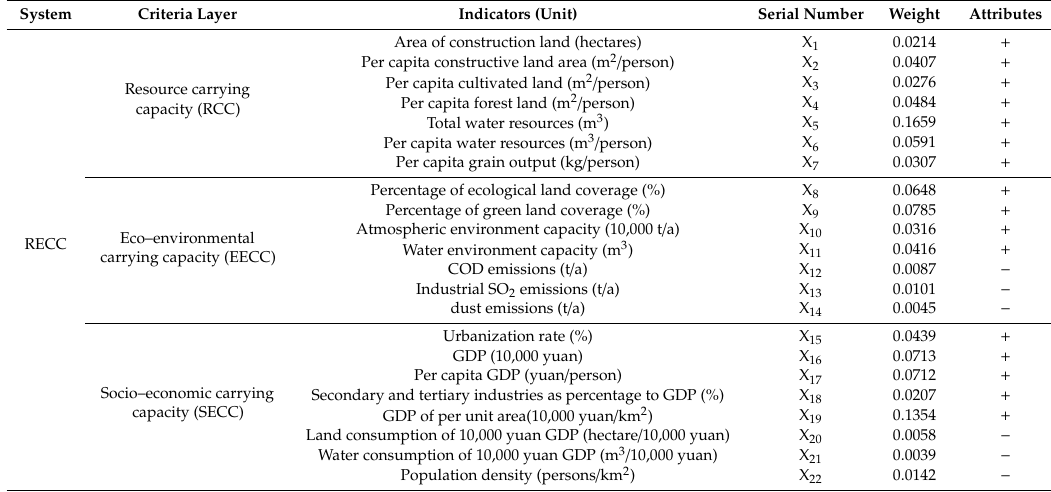
Table 1. Evaluation index system of the resource–environmental carrying capacity